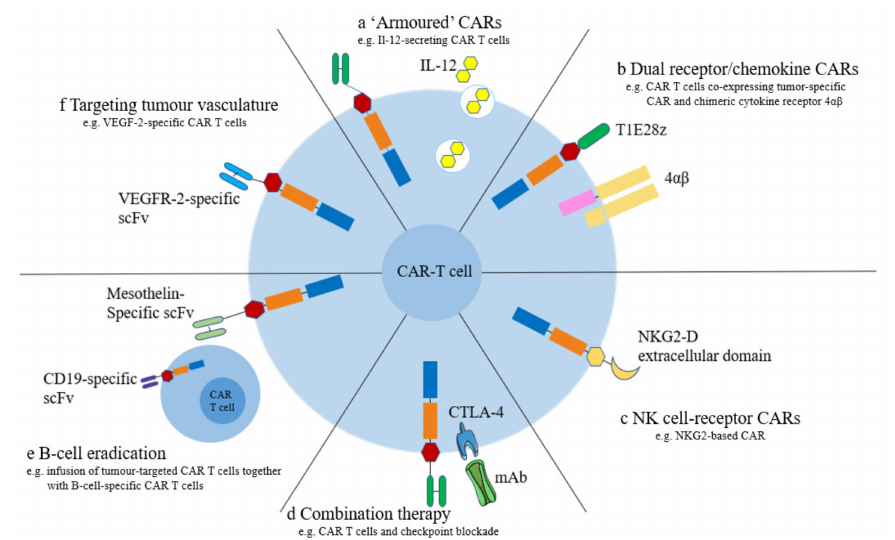
Figure 6. Schematic diagram of six methods to improve the therapeutic effect of CAR-T-cell